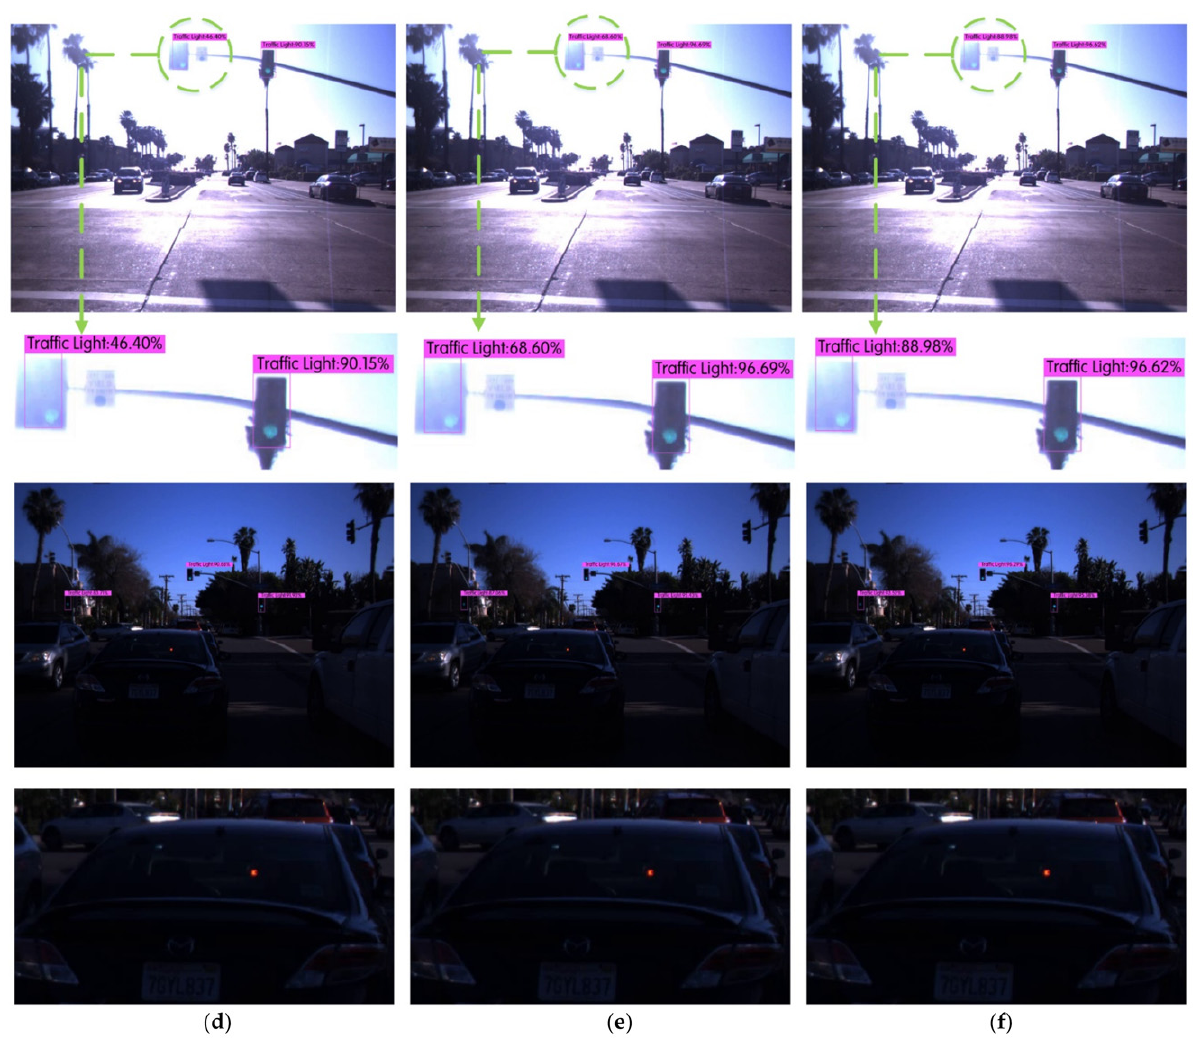
Figure 9. Comparison of detection results using multiple algorithms for traffic lights in different scenarios in the LISA data set. ( a ) Faster R-CNN. ( b ) YOLOv3. ( c ) YOLOv4. ( d ) YOLOv4-v1. ( e ) YOLOv4-v2. ( f ) Improved